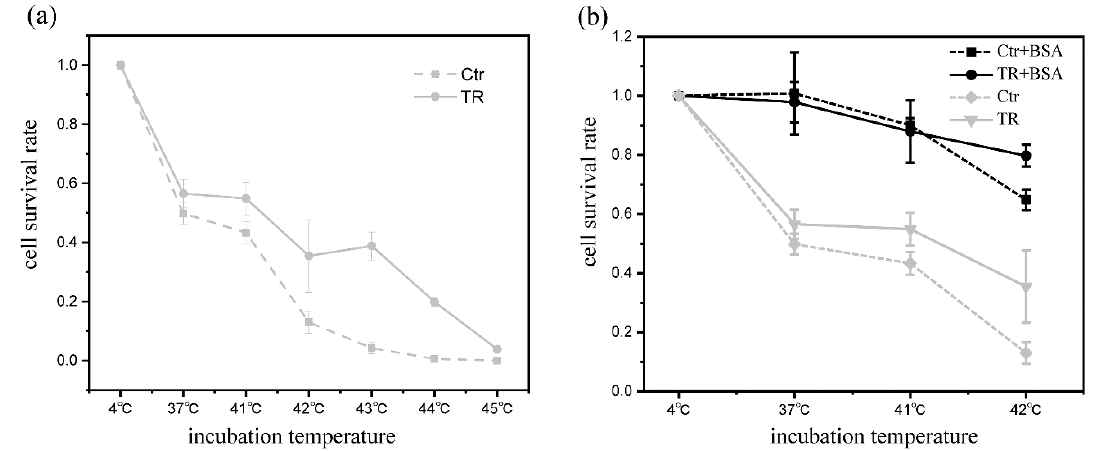
Figure 3. Effects of the incubation temperature and BSA on cell survival. ( a ) The survivals in medium without BSA. ( b ) The survivals in medium containing 5% BSA. The ctl (the cells cultured at 37 °C) and TR (the cells cultured at 41 °C) cells were incubated at the designated temperatures for 1/2 h, separately. Afterwards, the cells were grown at 37 °C, the formed colonies counted, and the survival rates calculated by following the procedure in Materials and methods. The results were derived from three independent repetitive experiments.